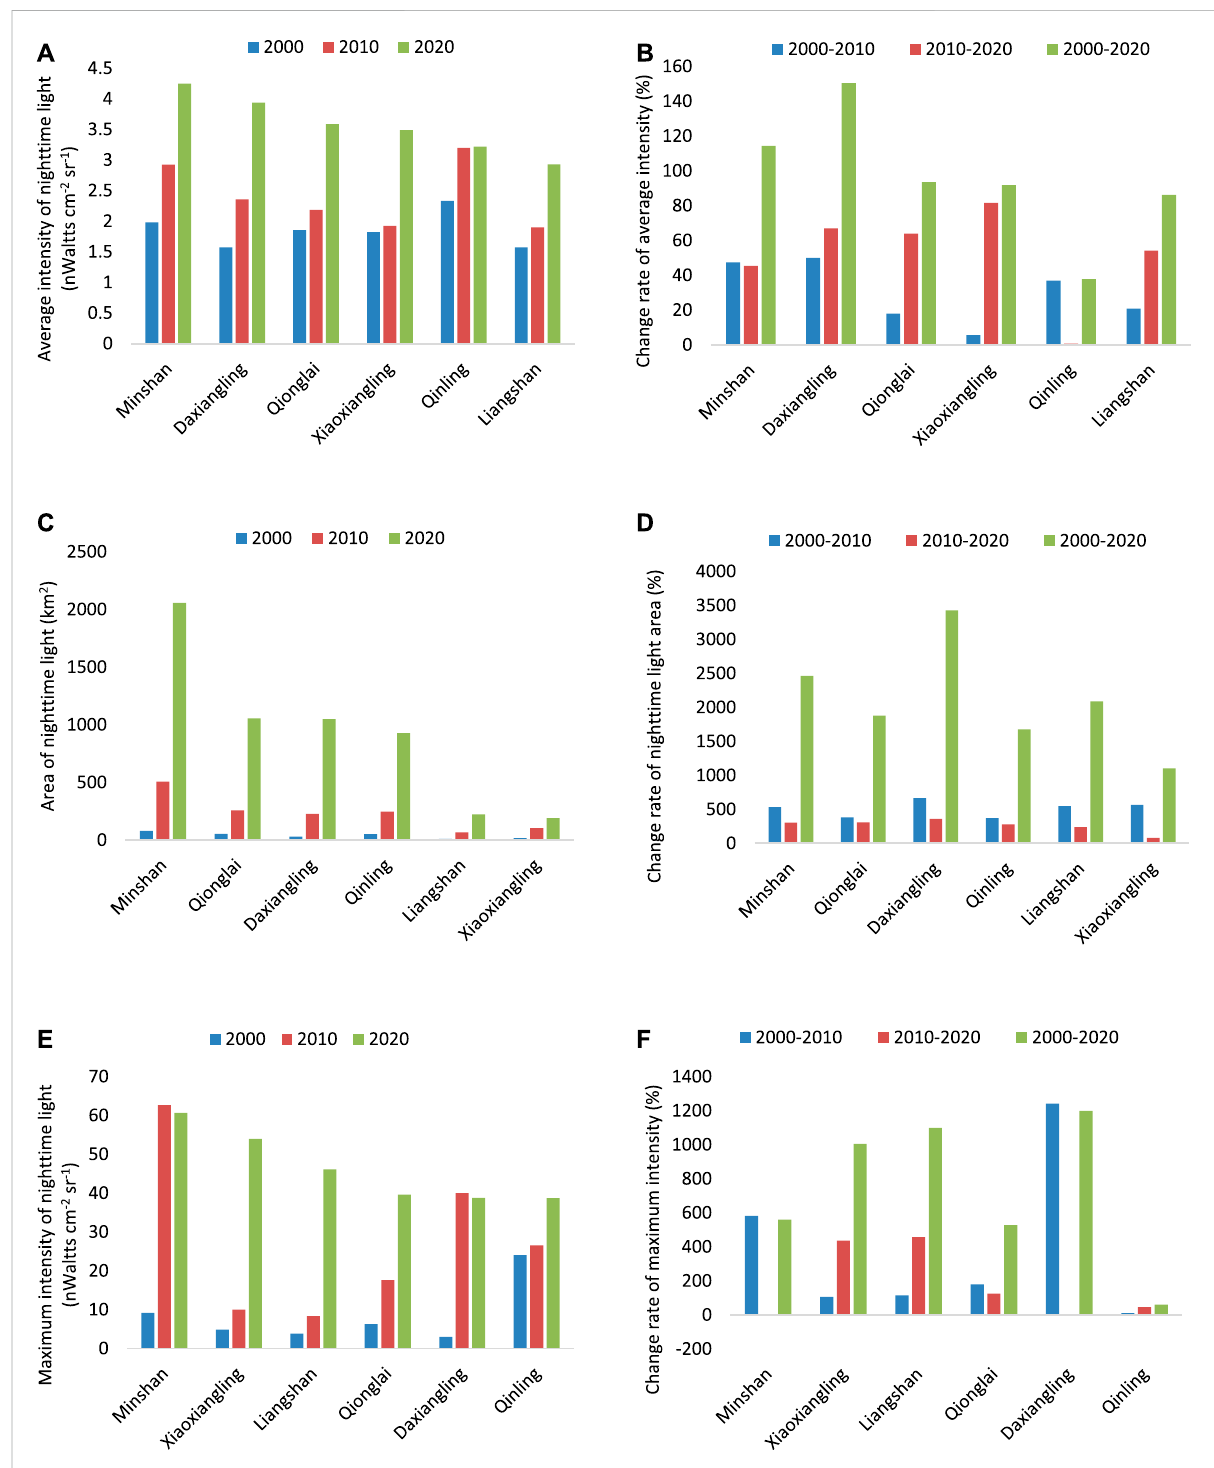
FIGURE 4 Intensity and area of nighttime light in different mountains where giant pandas inhabit. (A) Average intensities of nighttime light in the six mountains; (B) Changeratesofaverageintensities ofnighttimelightinthesixmountains; (C) Areaofnighttime lightinthesixmountains; (D) Change rates of nighttime light area in the six mountains; (E) Maximum intensities of nighttime light in the six mountains; (F) Change rates of maximum nighttime light intensities in the six